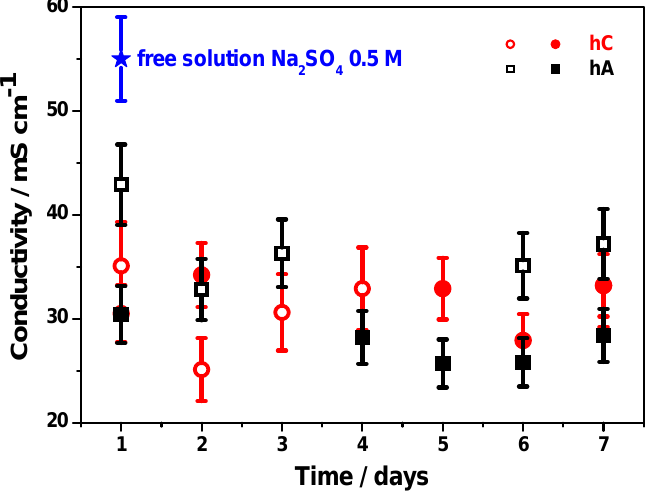
Figure 9. Ionic conductivity values at room temperature recorded on time for hA and hC swelled for 24 h in 0.5 M Na 2 SO 4 aqueous solutions (for each hydrogel determination has been carried out on two different